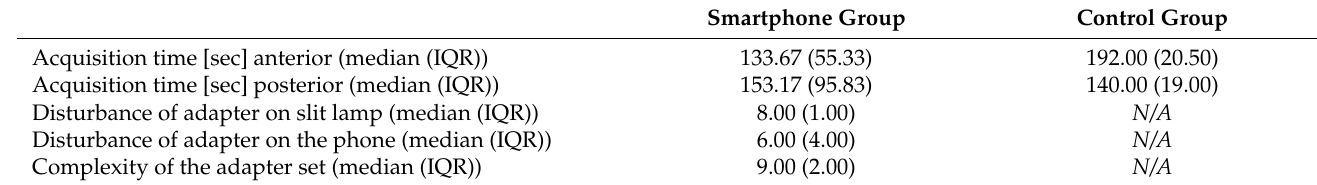
Table 4. Usability data.